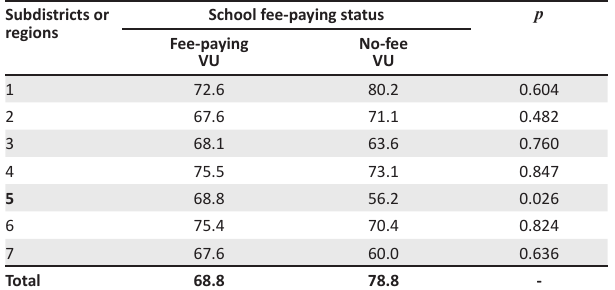
TABLE 2: Proportion of vaccine uptake among Grade 4 girls stratified by subdistricts and fee-paying status. Subdistricts or regions